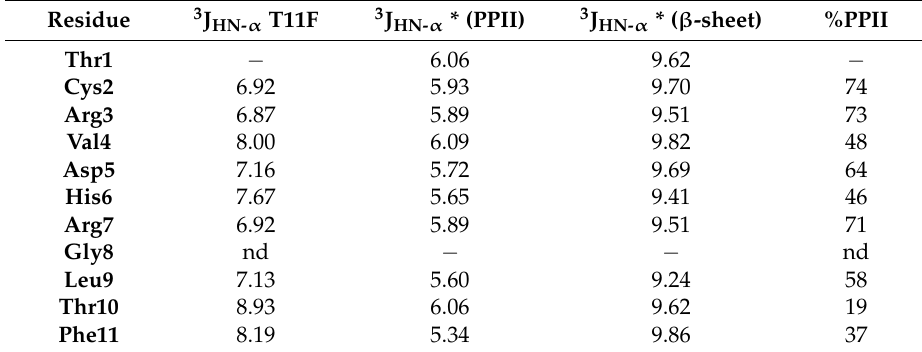
Figure 3. NH region of the 1 H-NMR spectrum of 3.25 mM T11F in 5% D 2 O/95% H 2 O at pH 5.0. Table 1. 3 J HN- α coupling constants (Hz) for T11F, reference 3 J HN- α values for PPII and β -sheet, and the PPII calculated population (%PPII) for each residue.